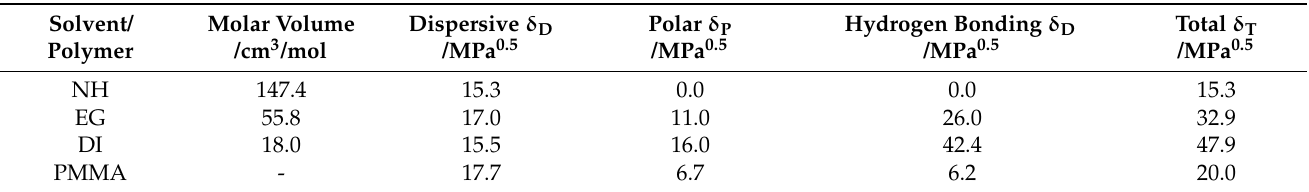
Table 1. Hansen and Hildebrand solubility parameters of PMMA and SCAs and their molar volumes (values selected from data listed in [1,2]).